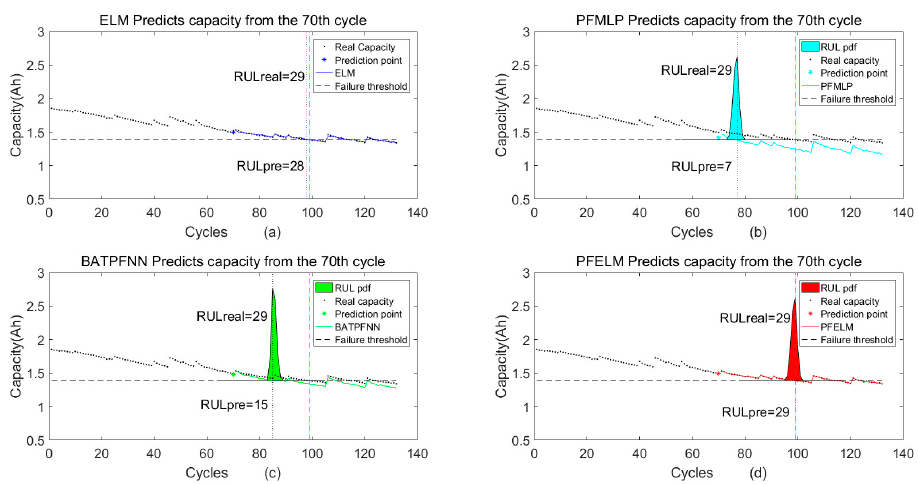
Figure 26. Predicting capacity from the 70th cycle by different algorithms: ( a ) ELM ; ( b ) PFMLP; ( c ) BATPFNN; ( d ) PFELM.